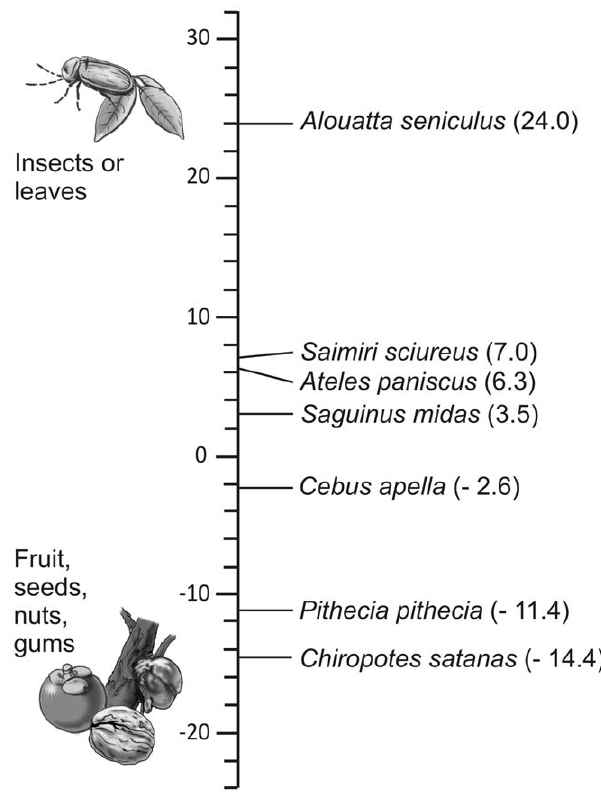
Figure 2. Comparison of the shearing quotients of the different primates of Cachoeira Porteira. Low values indicate a diet based on fruit, gums or even seeds whereas a high SQ points towards a leaf or insect based diet.